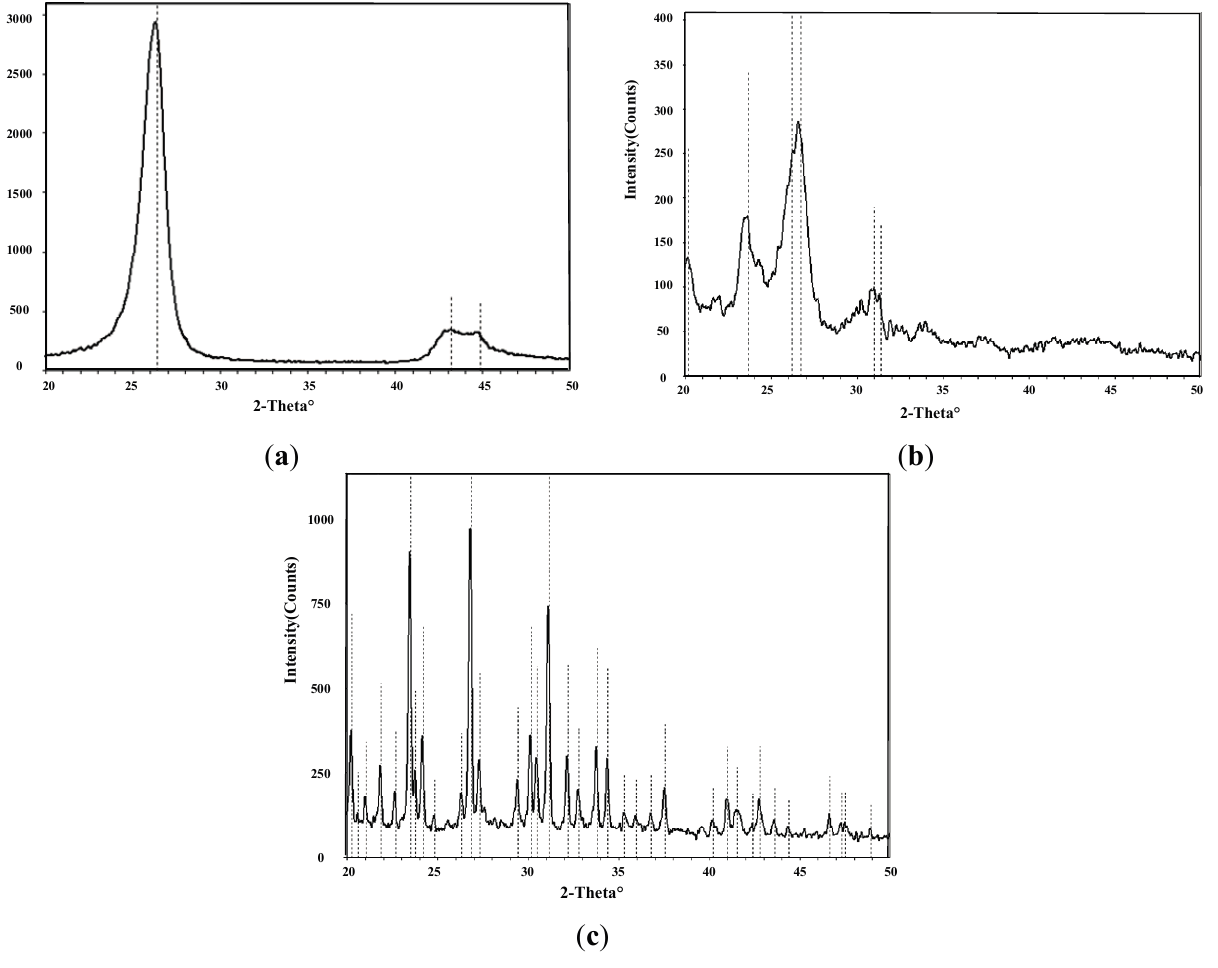
Figure 5. ( a ) XRD of MWNTs; ( b ) XRD of molecular sieve-deposited MWNTs; ( c ) XRD of K-type molecular sieve.